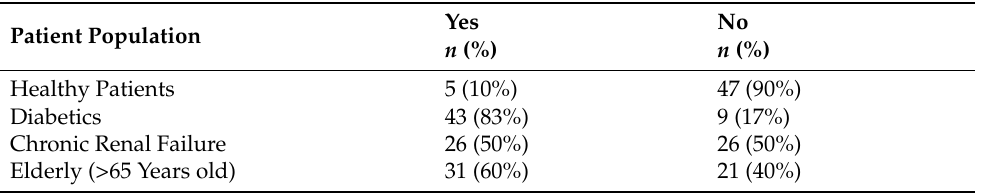
Figure 1. Distribution of responses of 52 GPs to the question “How useful have you found ABI to be in the diagnosis and clinical management of asymptomatic and symptomatic PAD patients?”. Table 2. Distribution of results to the question, “Which of the following patient population is the ABI considered a good PAD screening tool in your opinion?” ( n = 52).